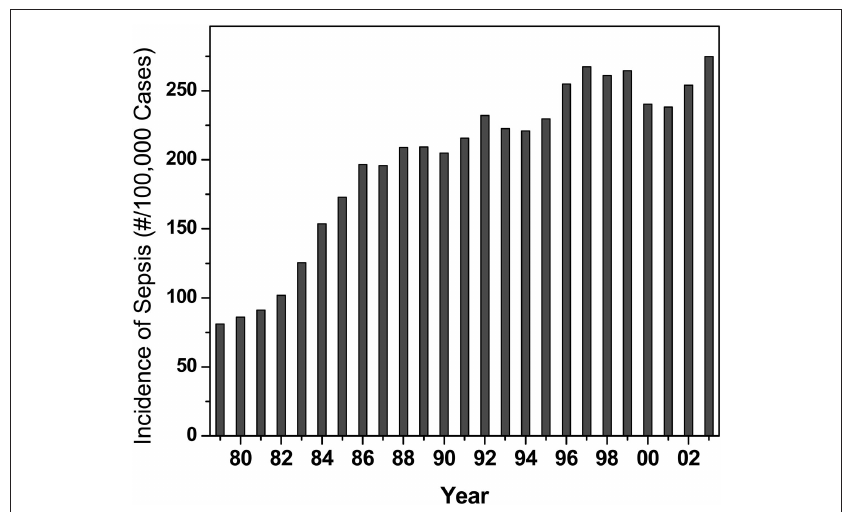
Figure 1 | incidence of sepsis in the uS Data provided by greg